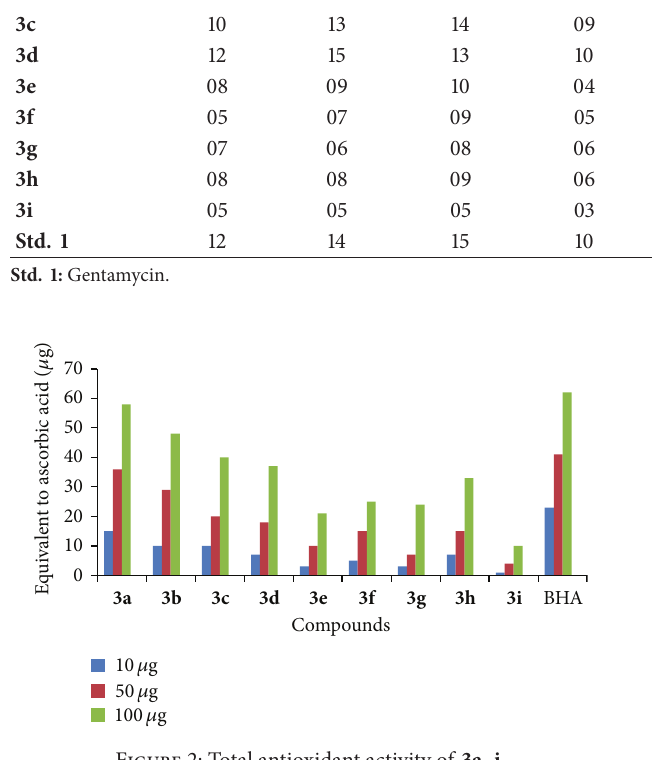
Figure 2: Total antioxidant activity of 3a–i .